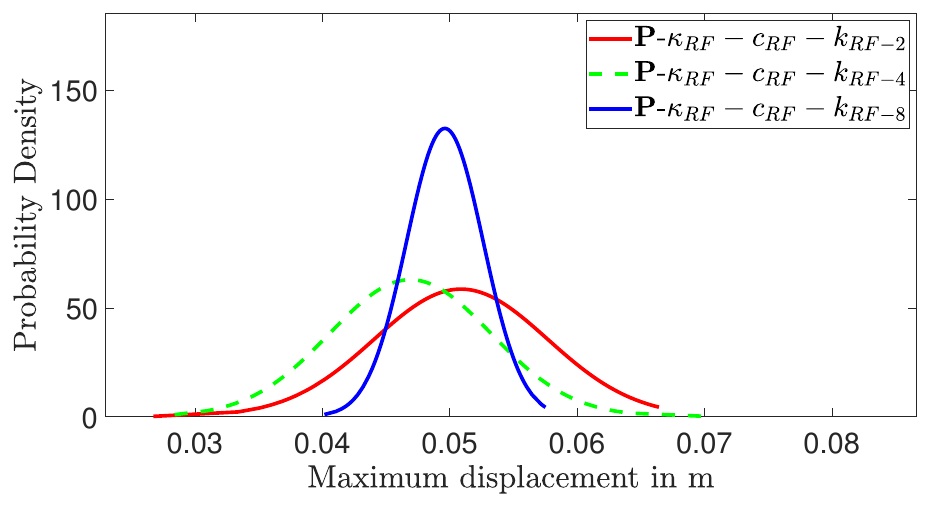
Figure A6. PDFs of the maximum displacement in m for porous analyses with random field repre- sentation for the stochastic material variables. κ RF , κ RF , κ RF stands for correlation length b = 2, 4, 8 2 8 4 for κ , respectively, whilst c RF , c RF , c RF stands for correlation length b = 2, 4, 8 for c, respectively, 2 8 4 and k RF , k RF , k RF stands for correlation length b = 2, 4, 8 for k. Subplot ( a – d ) stand for eccentricity 2 8 4 0, h , h , h , respectively. 6 3 12